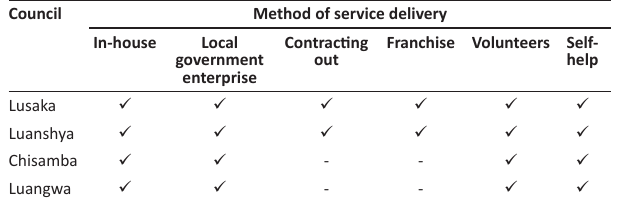
TABLE 3: Methods of service delivery